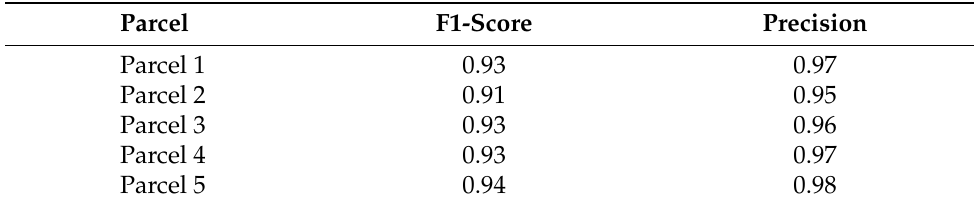
Table 1. Segmentation